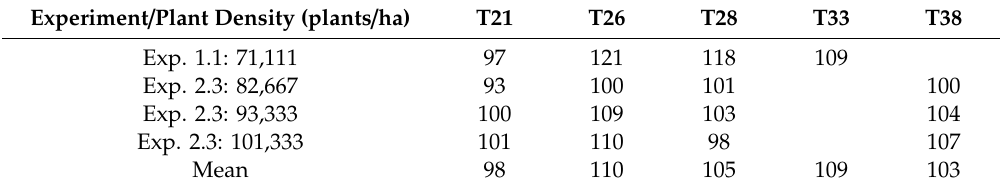
Table 8. Di ff erences in centimeters between height of stigmas of lines T21, T26, T28, T33 and T38 and the tassel of line